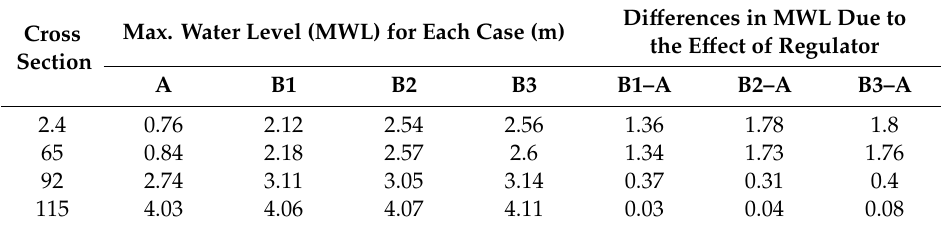
Table 4. Di ff erences in water levels between case A and cases B1–B3 for a wave of 200 m 3 / s.